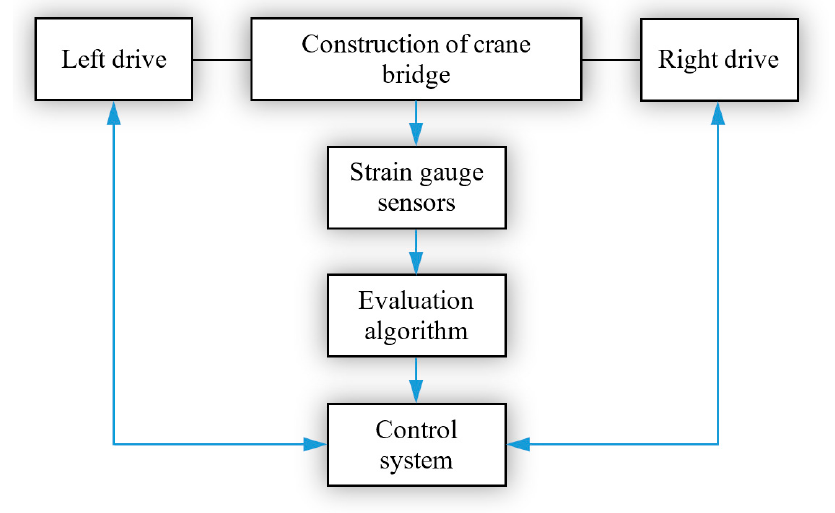
Figure 13. Measuring chain proposed for elimination of crane skewing.